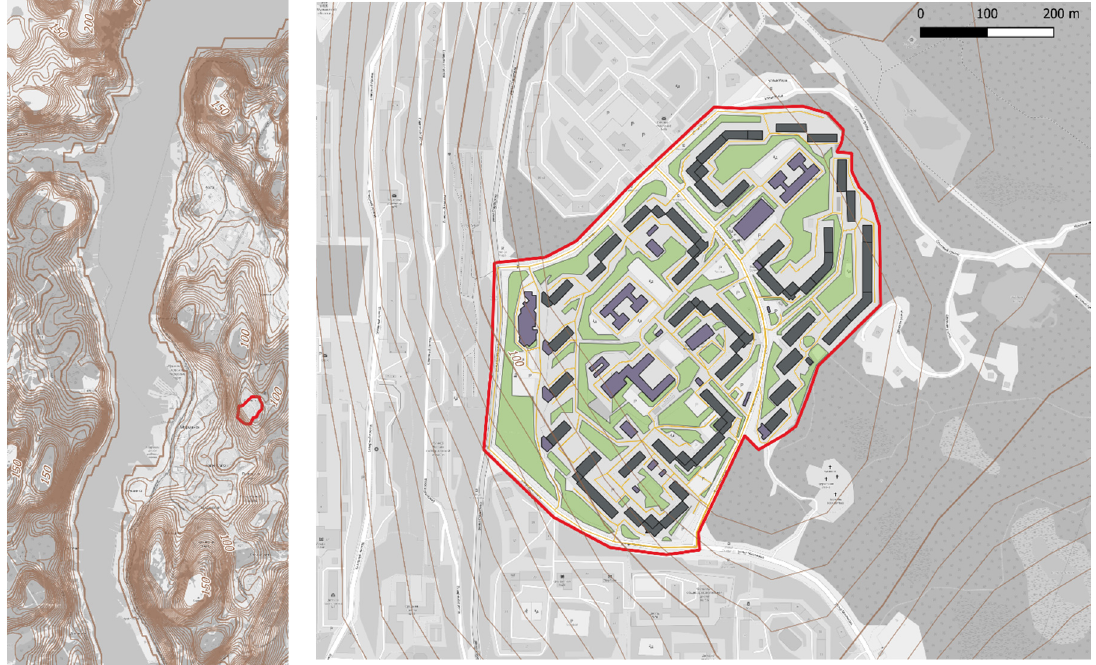
Figure 19. Design project of neighborhood 403, Murmansk, including the topographic contour and the prevailing wind direction.